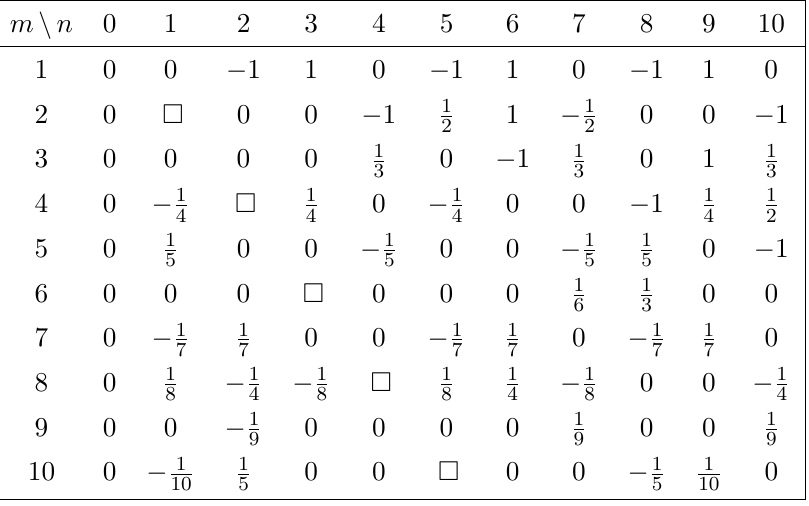
Table 4 . Table of values of (cid:17) ( m; n ). Note that m 2 (cid:17) ( m; n ) is always integer and that (cid:17) ( m; n ) is only a function of the quotient n . The squared boxes mark the slots corresponding to pairs ( m; n ) m that are proportional to the pair (2 ; 1) for which the regulator (cid:15) fails (see the last paragraph of appendix